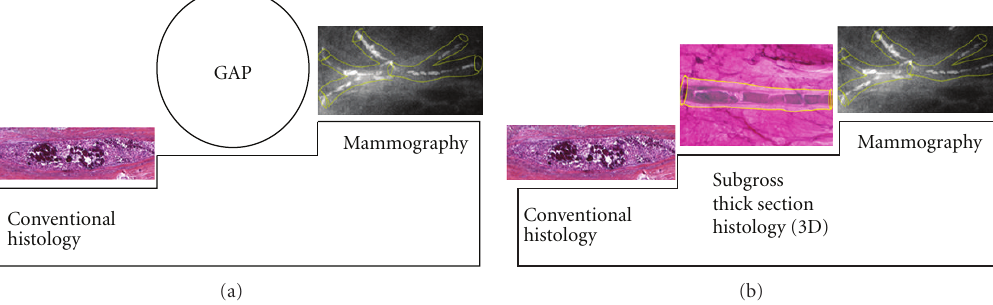
Figure 2: (a) A stepwedge expressing the discrepancy between the low-resolution mammographic image and high-resolution histologic image. The mammogram shows calcifications localized in a well-defined structure of the breast (ducts), while the interpretation of the histopathologic finding emphasizes the cellular details not seen by the radiologists. There is a communication gap since the radiologist expects a detailed description of tissue structure, in addition to the description of cellular features. (b) The communication gap can be overcome with the help of subgross (3D) histology. In this case the location of fragmented casting type calcifications and the intraductal pathologic process producing them can be clearly seen on the subgross (3D) image, providing excellent radiologic-pathologic correlation.